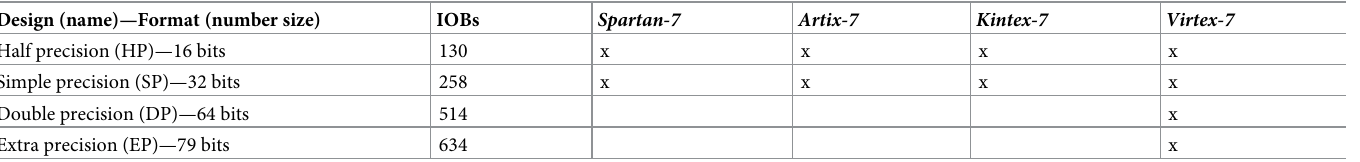
Table 2. Designs and used